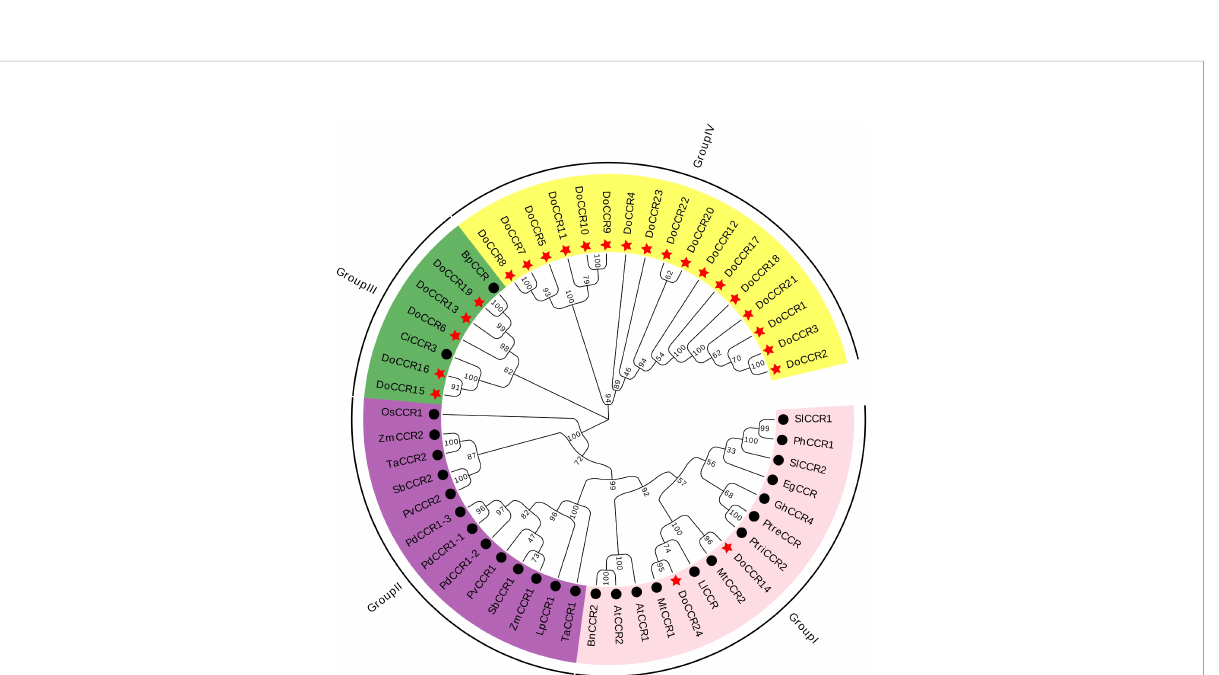
FIGURE 3 Phylogenetic tree of DoCCRs and 28 charaterized CCRs from other plant species. The neighbor-joining (NJ) tree was constructed by MEGA11 with 1,000 bootstrap replicates. The purple shade indicates monocot CCRs, and other shades indicate dicot CCRs. The red star indicates the DoCCRs and the black circle indicates the functional CCRs from other plants. At, A . thaliana ; Bp, B . platyphylla ; Bn, B. napus ; Ci, C. intermedia ; Do, D . odorifera ; Eg, E. gunnii ; Gm, G. mexicanum ; Ll, L. leucocephala ; Lp, L. perenne ; Mt, M. truncatula ; Os, O. sativa ; Pv, P. virgatum ; Pd, P. dilatatum ; Ph, P. hybrida ; Ptre, P. tremuloides ; Ptri, P. trichocarpa ; Sl, S. lycopersicum ; Sb, S. bicolor ; Ta, T. aestivum ; Zm, Z. mays . Detailed information of all CCRs from other plants are showed in Table S1.